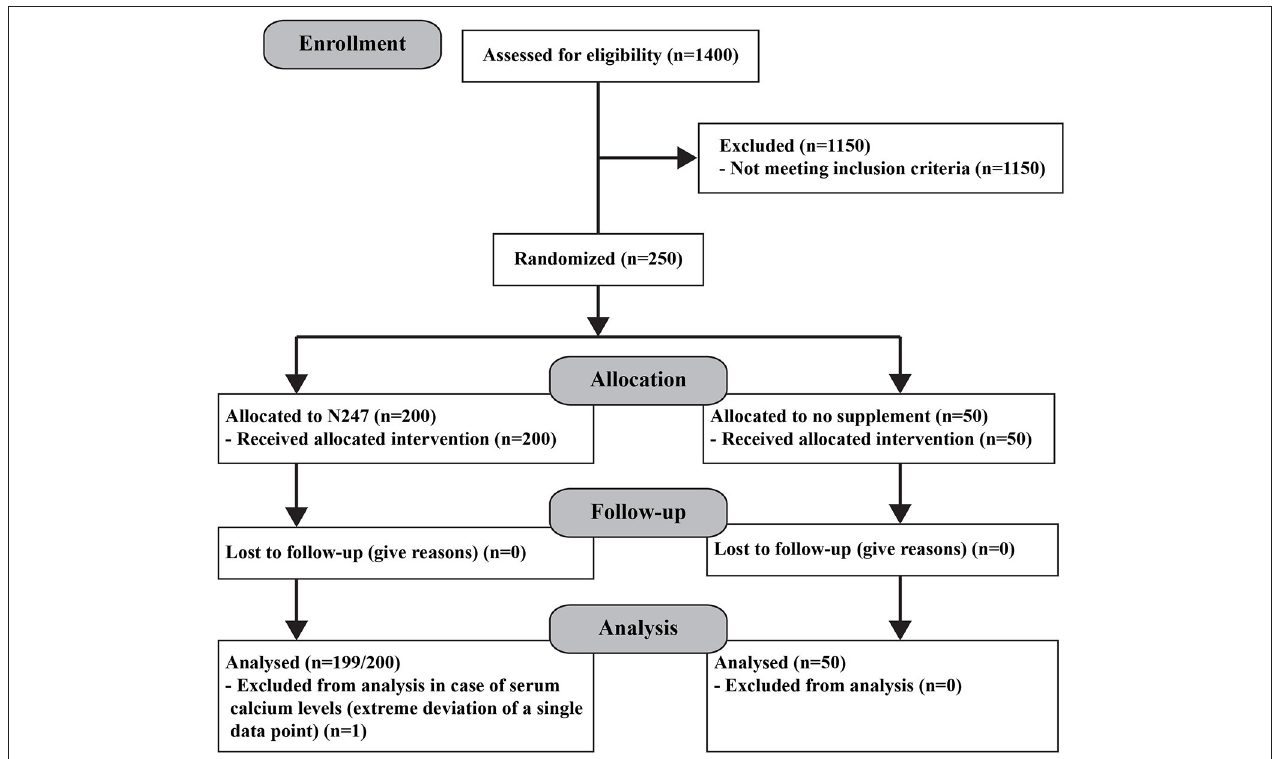
FIGURE 1 | Consort diagram.